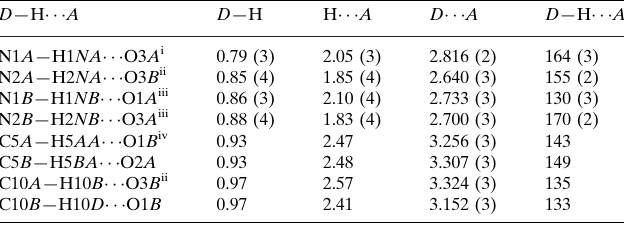
molecules into two-dimensional networks parallel to the ab plane.